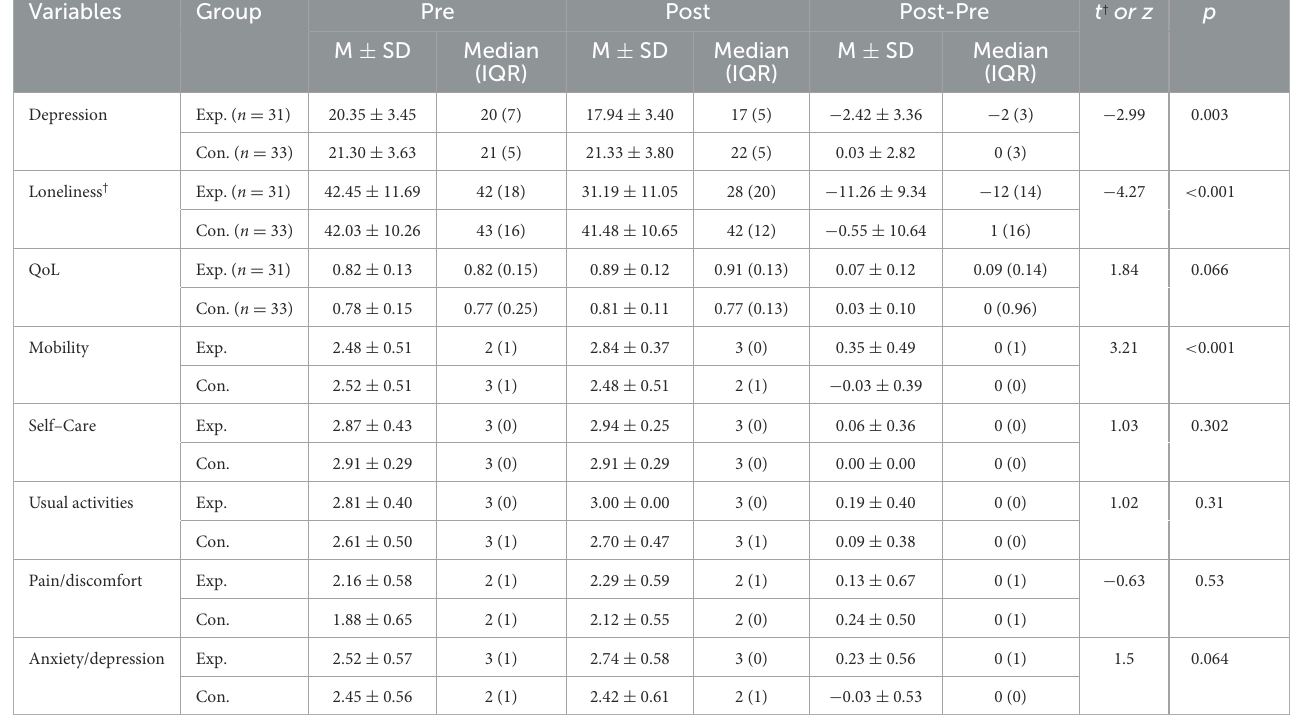
TABLE 4 Comparison of depression, loneliness and QoL ( N = 64). Variables Group